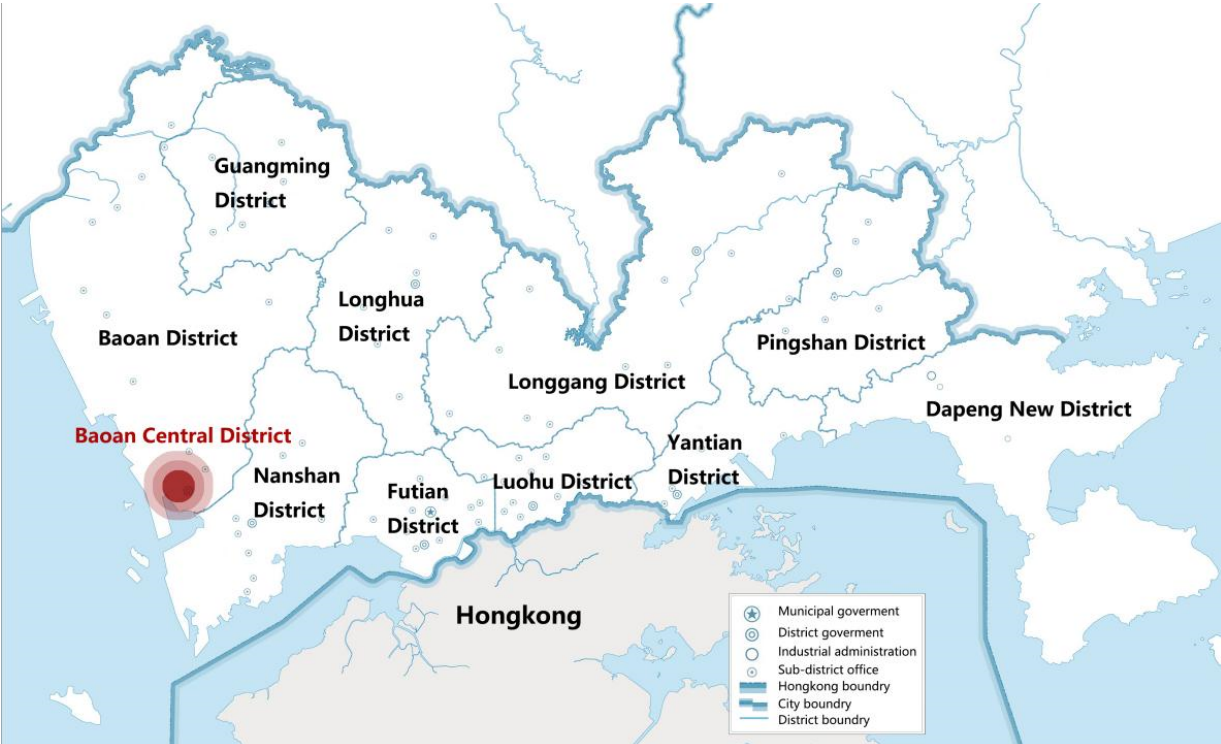
Figure 2. Location of study area (source: authors).